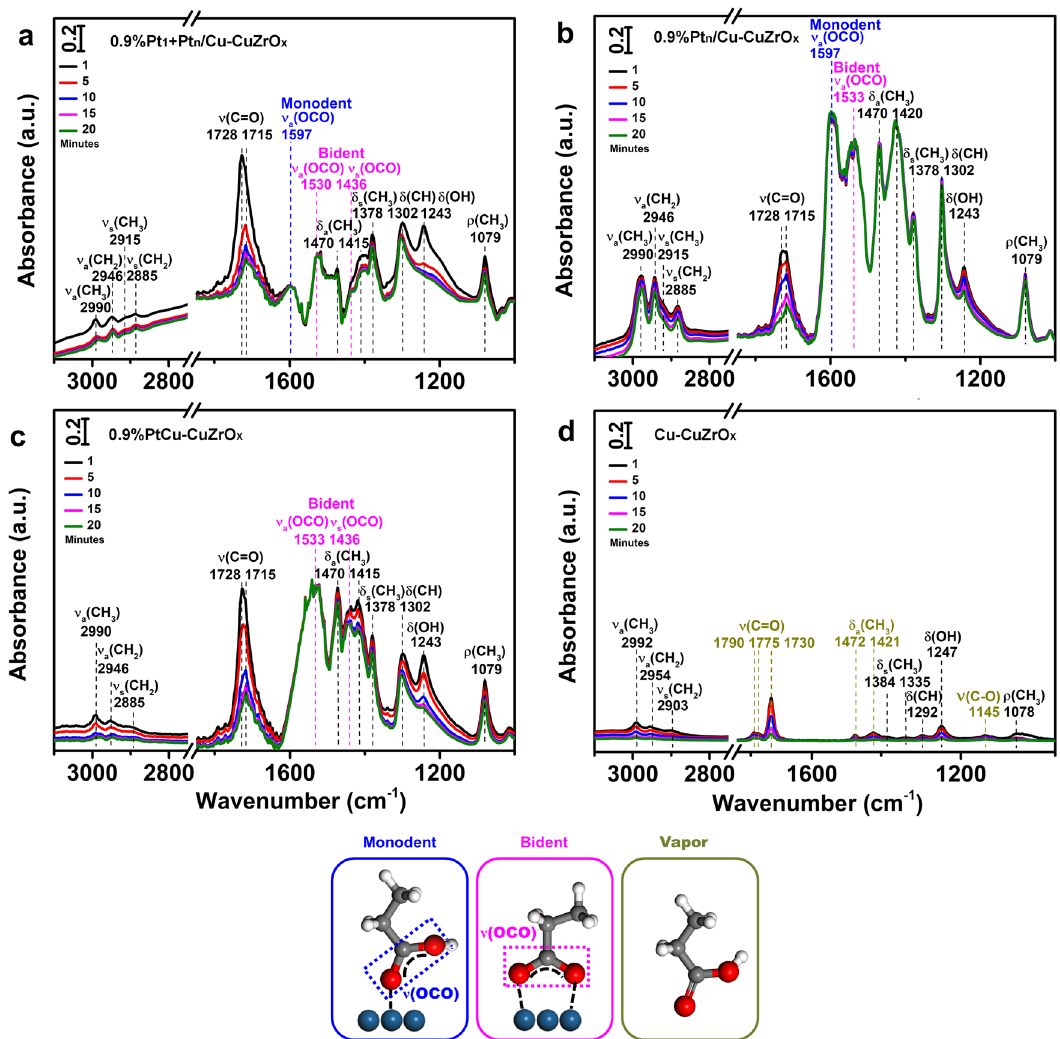
Fig.7|Thedesorptionbehaviorofcarboxylgroups. InsituFT-IRspectraafterthe adsorptionofpropionicacidfor30minfollowedbydesorptionatdesorptiontimes of1,5,10,15,and20min(fromtoptobottom)on0.9%Pt 1 +Pt n /Cu-CuZrO x ( a